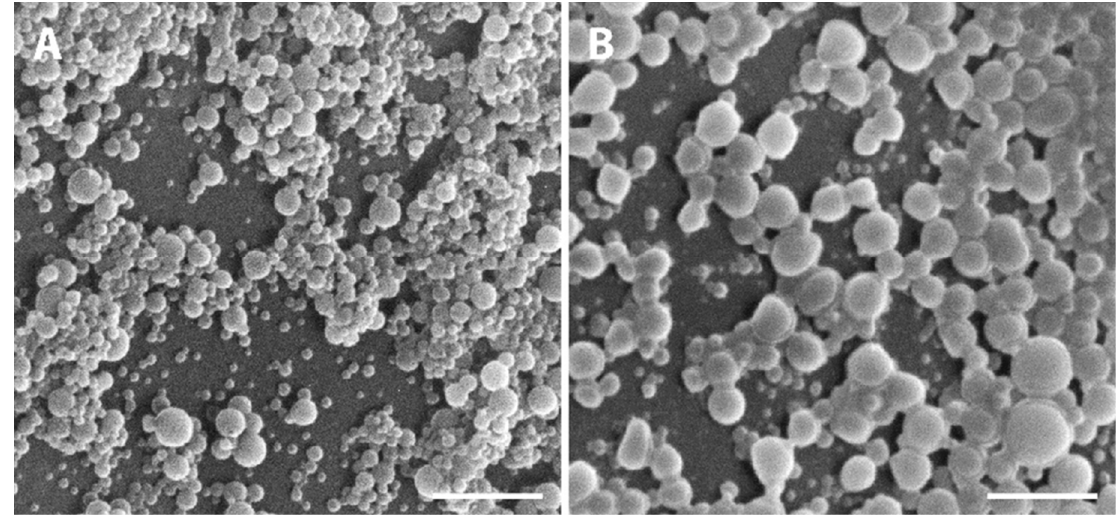
Figure 3. Representative SEM micrographs showing the PLGA NPs. ( A ) Empty PLGA NPs and ( B ) insulin-loaded NPs. Scale bars correspond to 3 µ